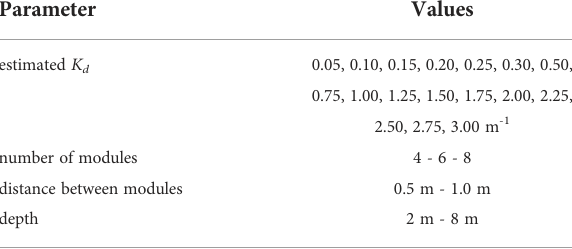
TABLE 2 Parameters evaluated during the sensitivity analysis.